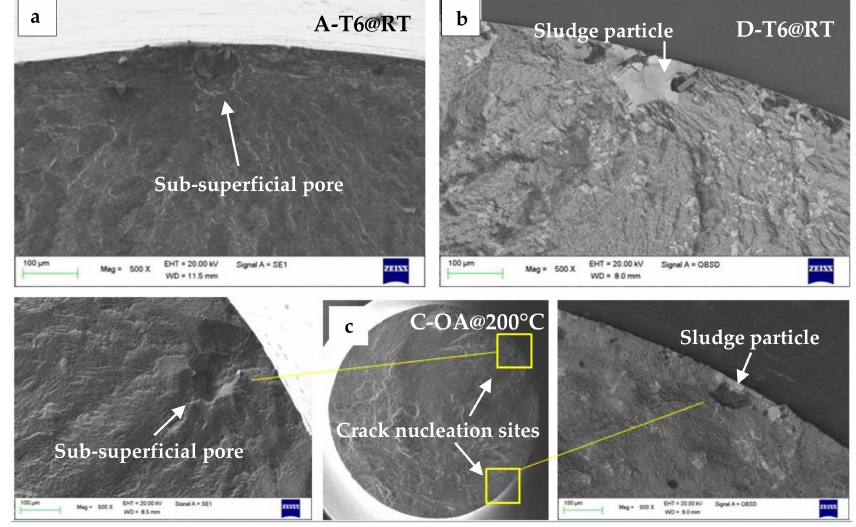
Figure 8. SEM images of fracture surfaces: ( a ) sub-superficial pore inducing crack nucleation in A-T6 alloy; ( b ) crack nucleated on sample surface by a sludge particle in D-T6 alloy; ( c ) multiple crack nucleation in C-OA alloy tested at 200 ◦ C, caused by sub-superficial pore and superficial particle.